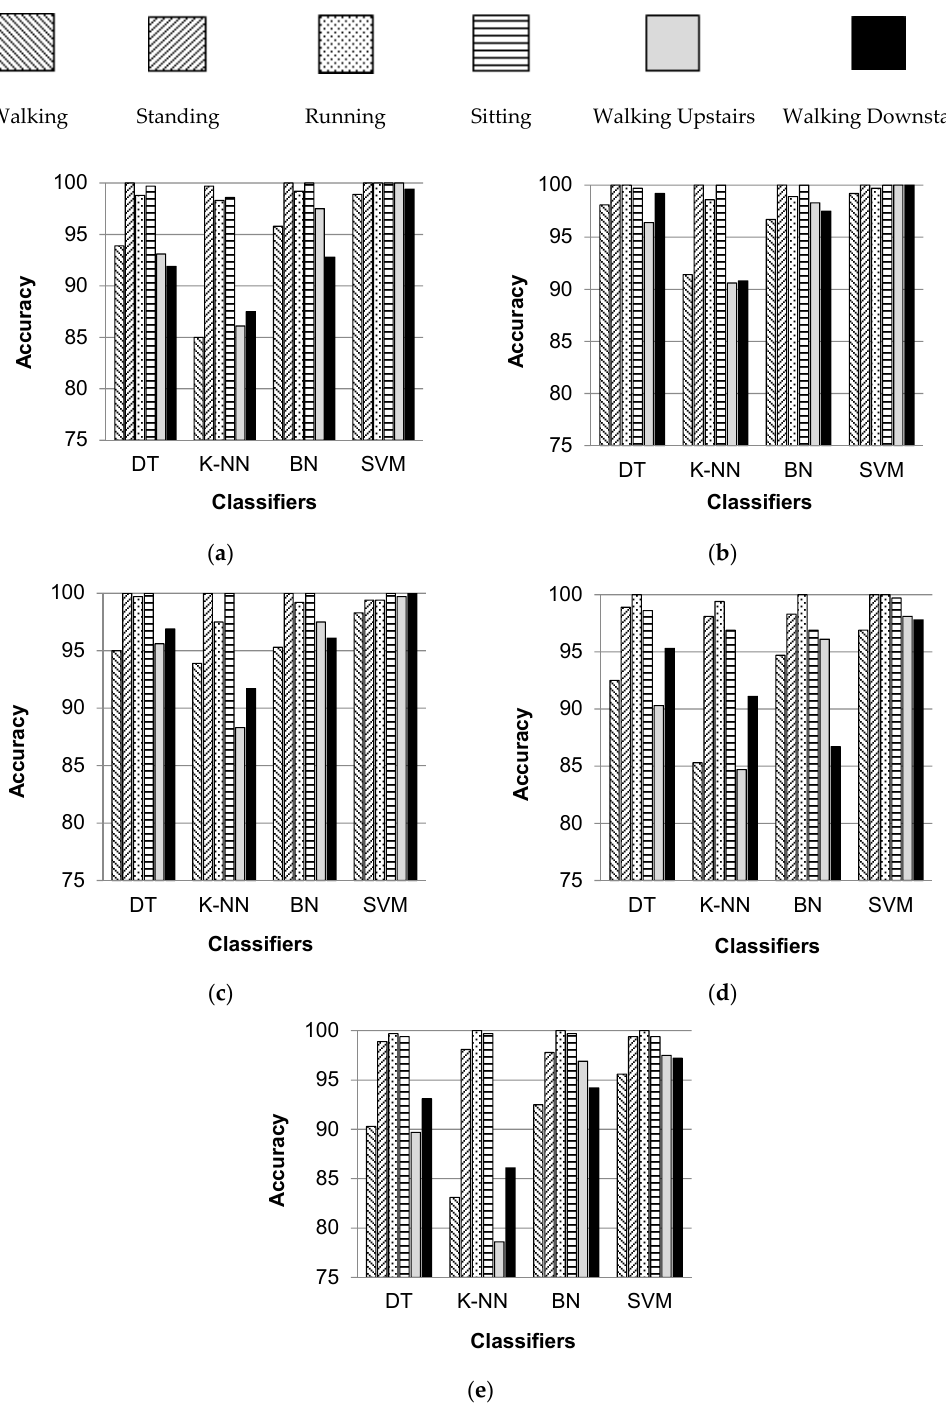
Figure 5. Individual classification accuracies of selected activities when classified with DT, K-NN, BN, and SVM classifiers for five different body positions: ( a ) waist; ( b ) left thigh; ( c ) right thigh; ( d ) upper arm; ( e ) wrist.